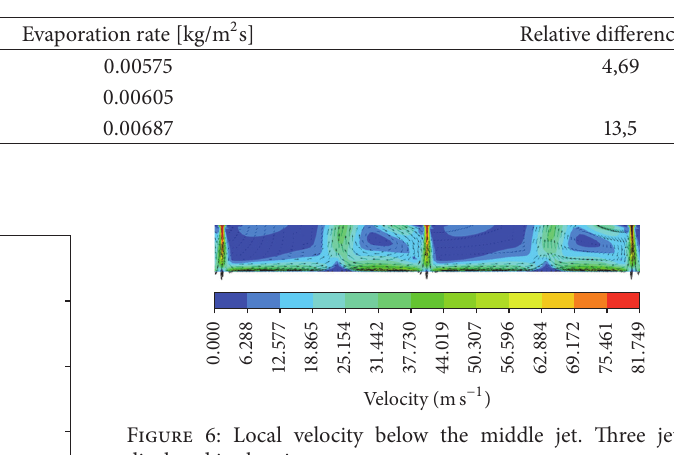
Table 2: Area average evaporation rates and relative difference compared to simulations where moisture is included as a two-component mixture of air and vapor.